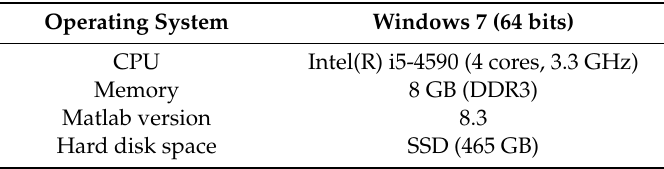
Table 1. Computer Table 1. Computer Configuration.